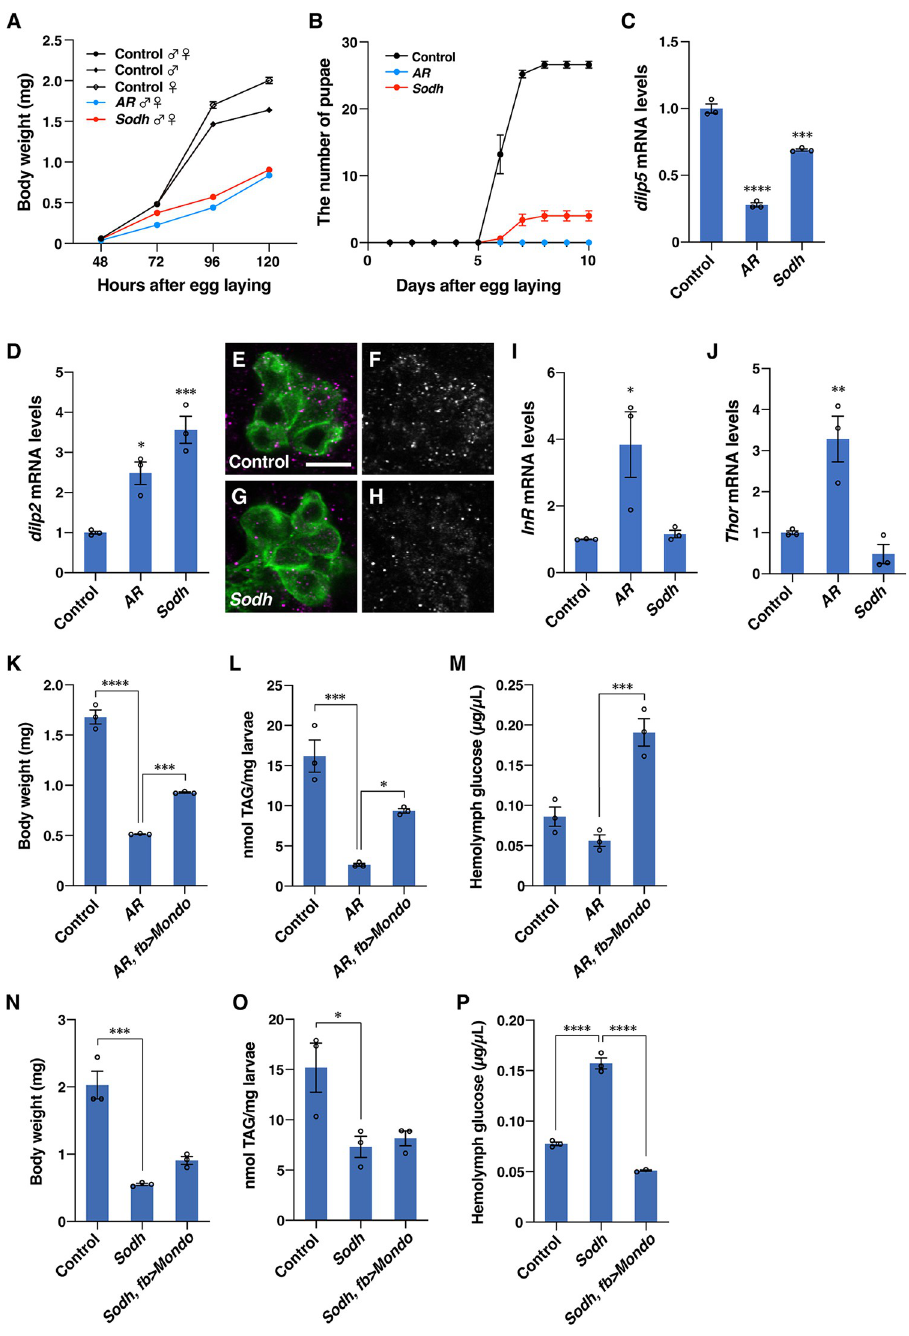
Fig 2. The polyol pathway is required for proper larval growth and physiology. ( A ) Larval body weight of AR and Sodh mutants reared on protein-rich diets; 10–50 animals per batch, n = 3 batches. The line graph shows mean ± SE. ( B ) Timing of pupal formation in AR and Sodh mutants. Thirty larvae were grown per vial and pupation was scored every 24 hours. n = 3 vials. The line graph shows mean ± SE. ( C–H ) Expression and secretion of Dilps in AR and Sodh mutant larvae. dilp5 and dilp2 mRNA levels were measured by RT-qPCR; 10 larvae per batch, n = 3 batches. Bar graphs show mean ± SE (C and D). Dilp2 was detected by anti-Dilp2 antibody (magenta), and insulin-producing cells were labeled by dilp2 > mCD8 :: GFP (green) (E and G). Single-channel images of the Dilp2 signals are shown in F and H. Scale bar represents 10 μ m. ( I , J ) InR and Thor mRNA levels were measured by RT-qPCR. ( K–P ) Body weight, whole body triacylglyceride, and hemolymph glucose levels in larvae of control, AR mutant, AR mutant with Mondo overexpression in the fat body ( AR , fb > Mondo ) (K–M), and control, Sodh mutant, Sodh mutant with